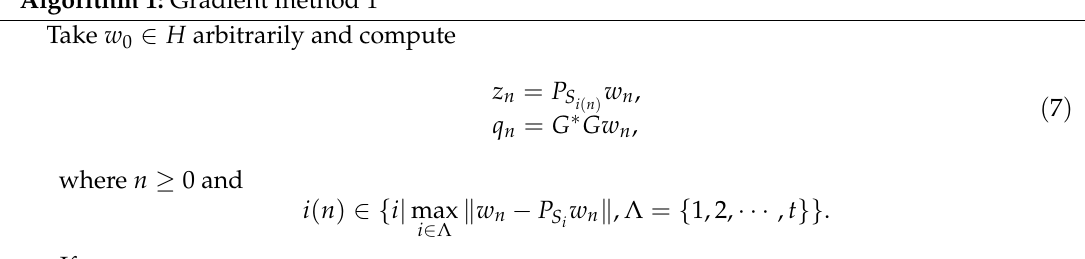
Algorithm 1: Gradient method